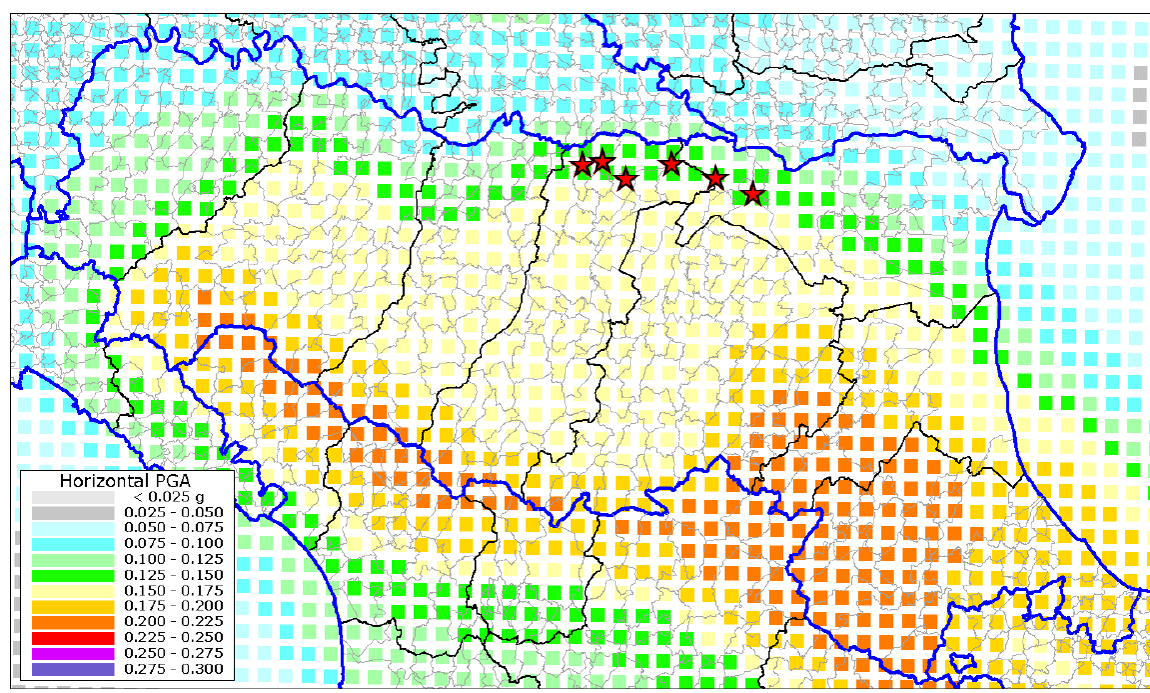
Figure 1. Seismic hazard map for the Emilia-Romagna region. The color at each grid point represents the expected horizontal PGA on rock with a10% probability of exceedance in 50 years (as indicated). Red stars, epicenters of the events of the 2012 Emilia sequence with magnitudes ≥ 5.